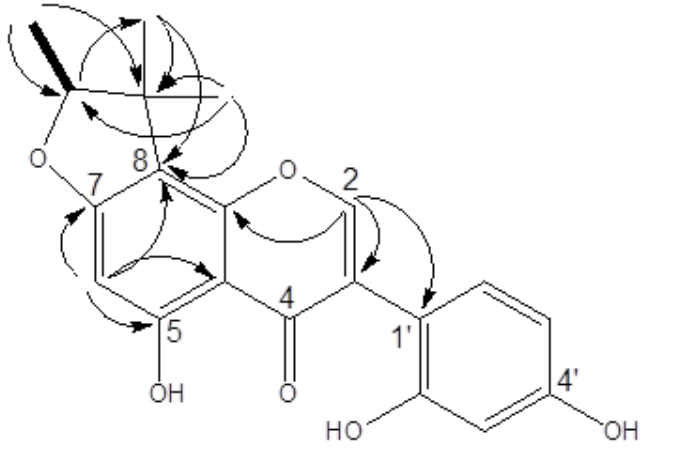
Figure 2. 1 H- 1 H COSY (correlation spectroscopy) and HMBC (heteronuclear multiple bond correlation) correlations of fleminigin ( 1 ).